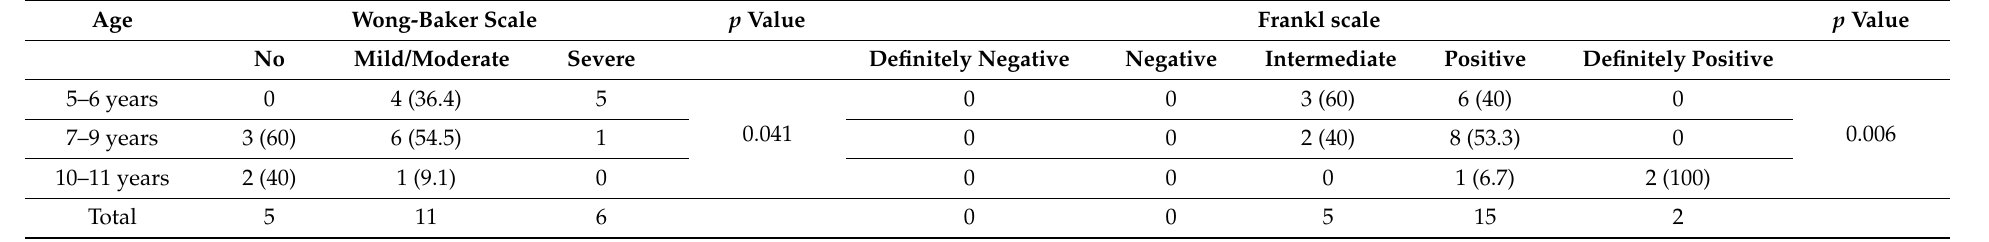
Table 2. Pain perception and attitude [ n (%)] using Wong–Baker and Frankl scales, respectively, among the different age groups and corresponding p values.